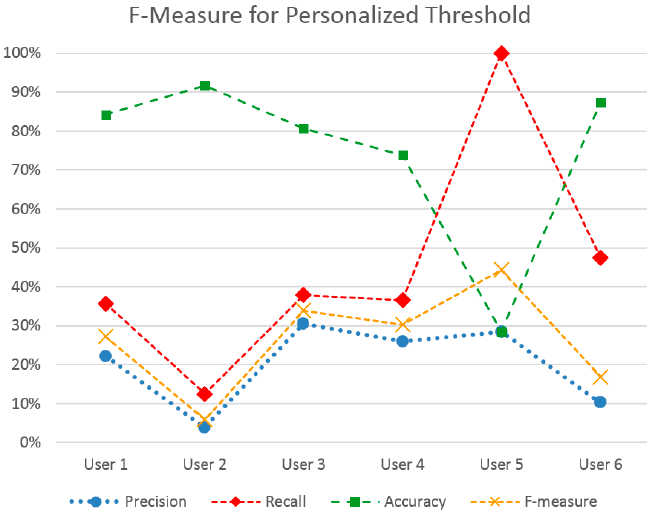
Figure 6. Performance metrics of the personalized threshold method to optimize F-Measure, per each user.